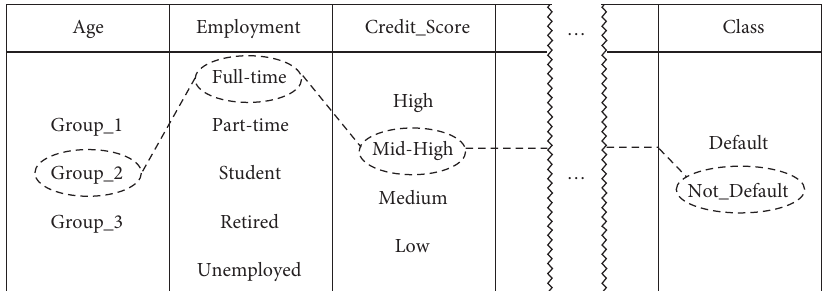
Figure 3: An example of rule construction by ants on the problem graph. The example replicates a credit default setting where the classification rules will suggest whether a given instance should be classified as a potential credit default risk or